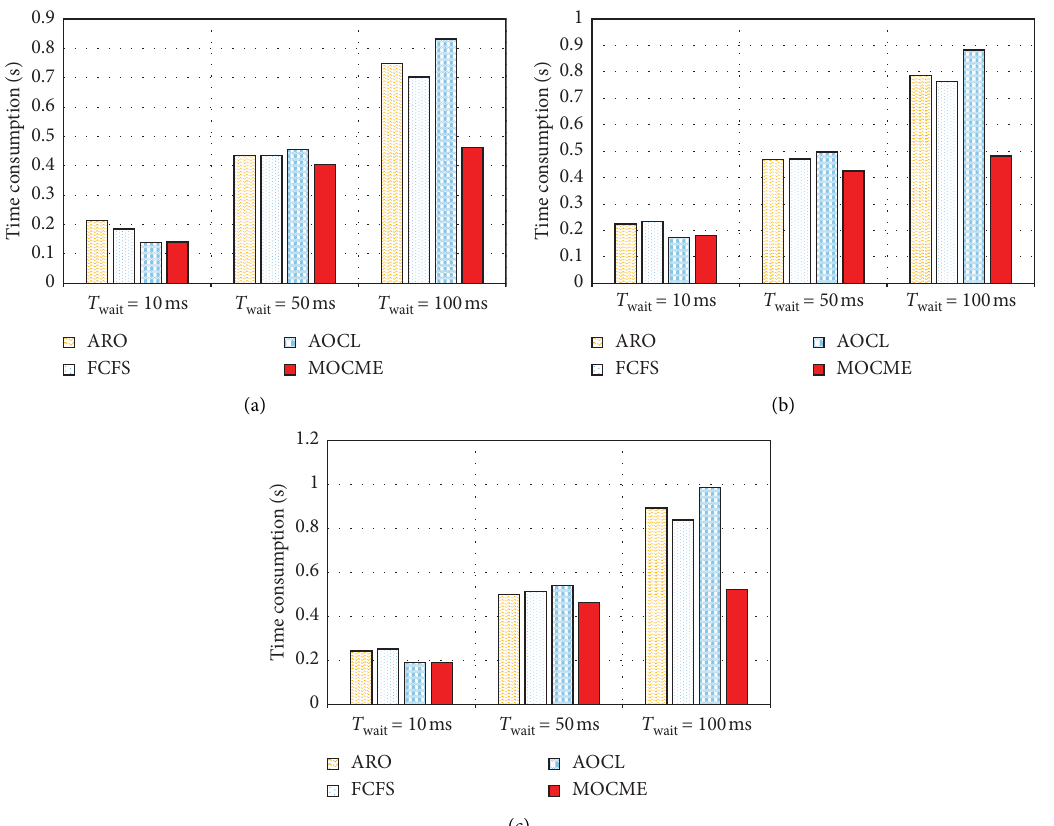
Figure 6: Average time consumption of MDs. (a) Number of WAs � 4. (b) Number of WAs � 5. (c) Number of WAs � 6.